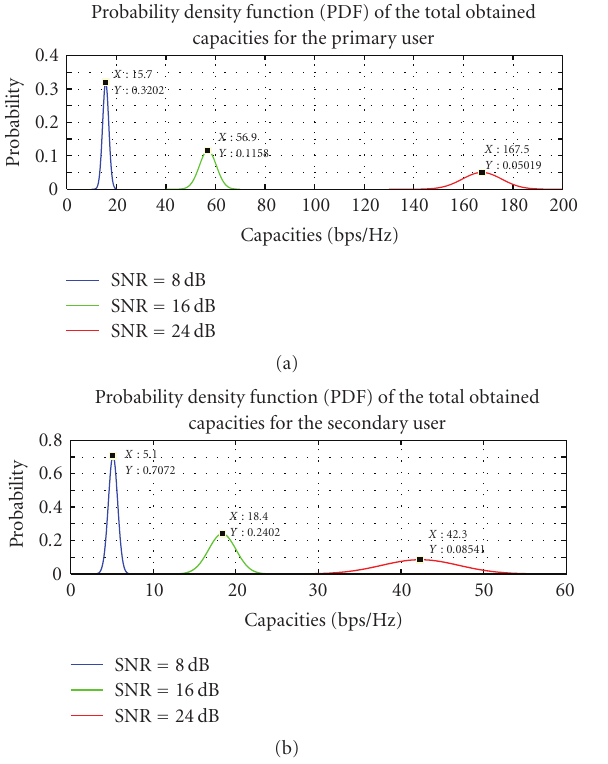
Figure 5: PDFs of the total obtained capacities (primary/secondary user), SNR = 8 dB, 16dB, and 24 dB.